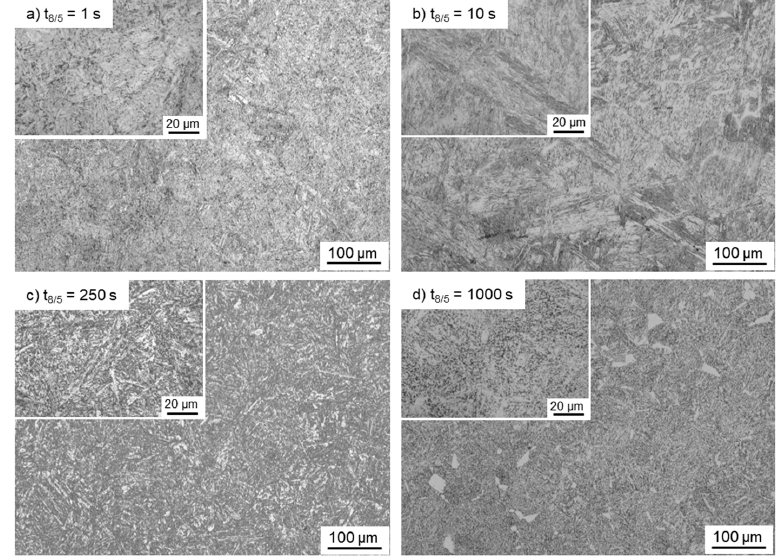
Figure 4. OM images of the microstructure of the dilatometer specimens heated to 1400 °C peak temperature and cooled with different t 8/5 -times of ( a ) 1 s; ( b ) 10 s; ( c ) 250 s; and ( d ) 1000 s at lower and higher magnification.